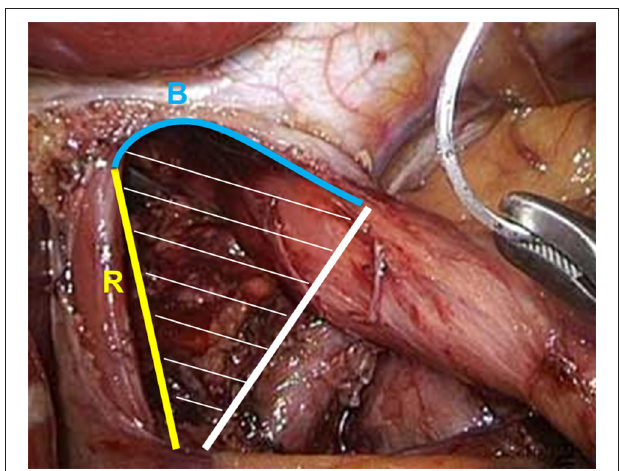
FIGURE 1 | Measurements of the HSA according to Granderath (14): the length of the crural commissure (R, yellow) and the length of the diaphragmatic commissure (B, blue; following the curve of the commissure) are measured and the HSA can then be calculated as B * R/2 or estimated by plotting B against R (see also Supplement Figure 2 ).